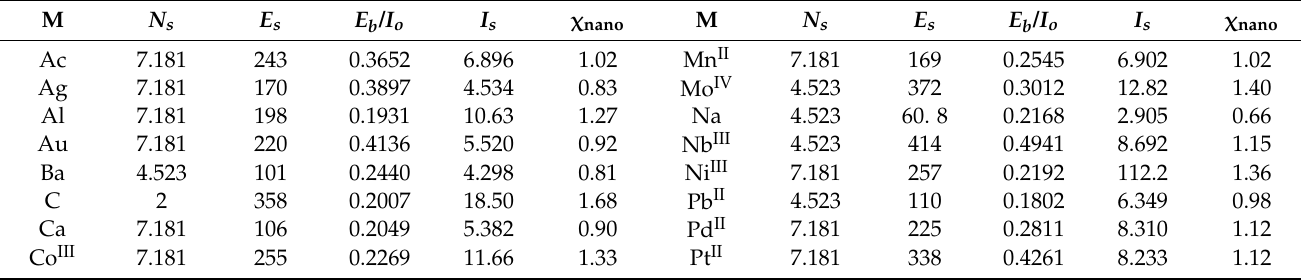
Figure 1. DSC/TGA curves for the oxidation of carbon with different grain sizes. Table 6. Electronegativities of nanosized elements.